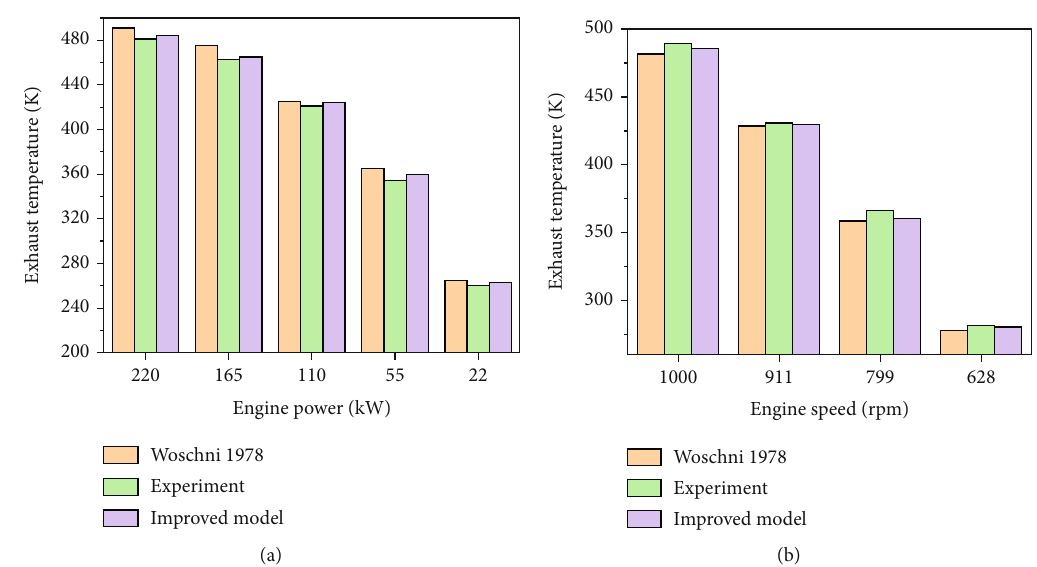
Figure 6: Variation of NO